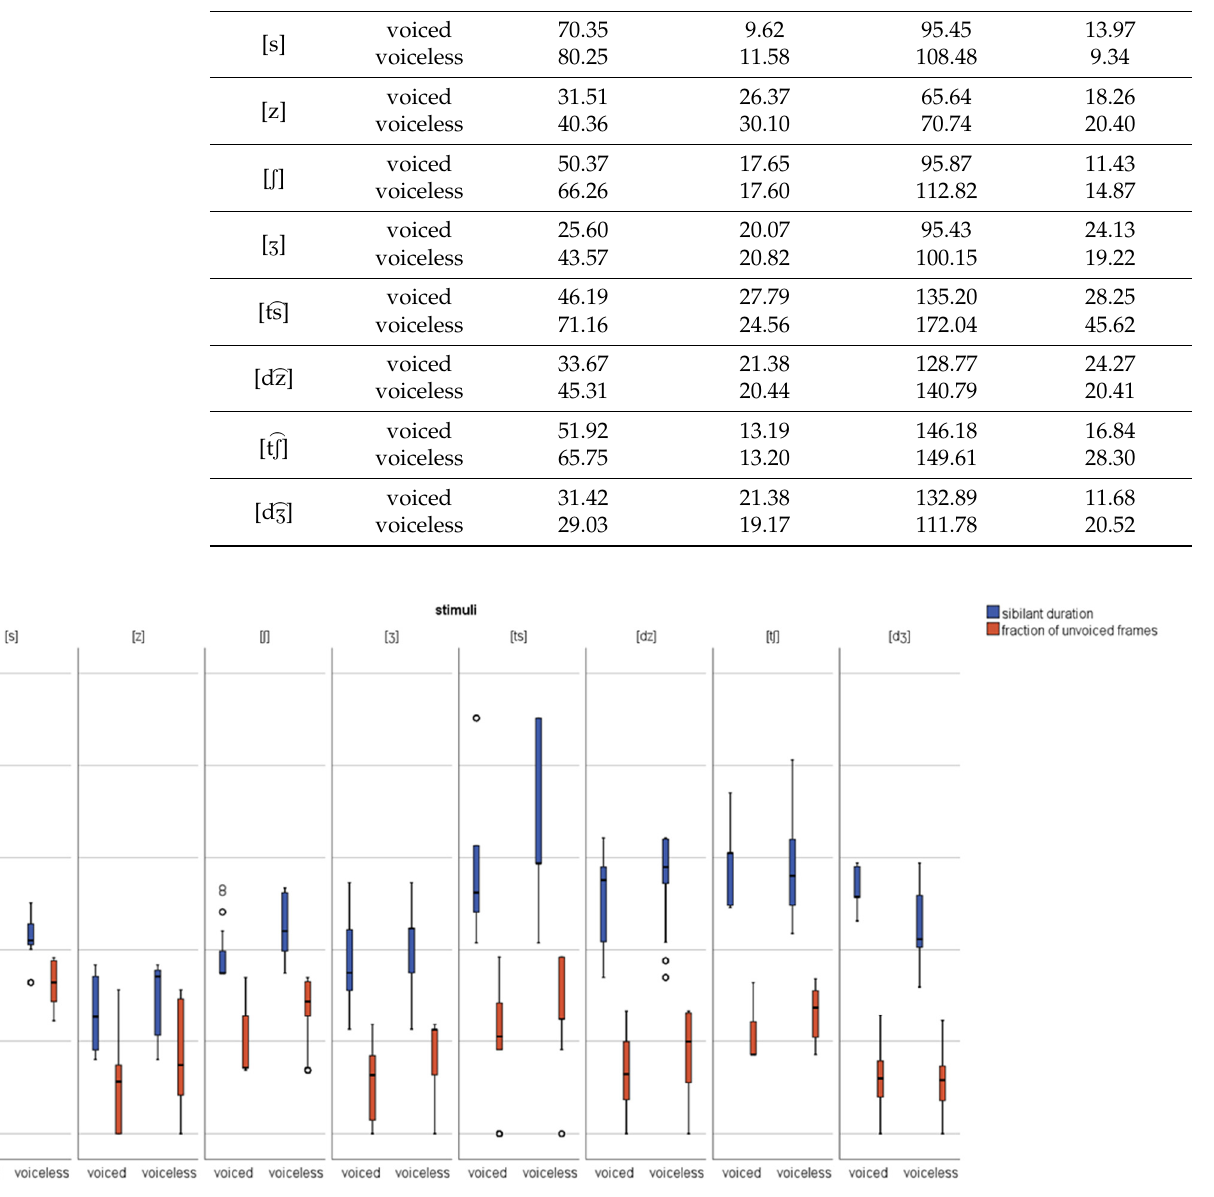
voiceless are in general longer and display a higher portion of unvoiced frames than those more cases than expected labelled as voiced when fraction of unvoiced frames and du- identified as voiced in every category, the only exception being [d ͡ ʒ ]. This general obser- ration increase (b 0 = 0.003, se = 0.001, t = 2.476, p < 0.013), though correct parsings still vation is confirmed by the statistical analysis. The mixed-effect binomial logistic regres- outweigh incorrect answers. Overall, the participants’ judgements confirm the acoustic sion (answer × fraction of unvoiced frames × duration) demonstrates that neither fraction measurements regarding duration and fraction of unvoiced frames, thus showing that of unvoiced frames nor duration condition the participant’s response as main effects; how- they are reliable parameters to establish voicing degree, which seem to be acoustically and ever, two- and three-way interactions (sibilant type × fraction of unvoiced frames, sibilant perceptually related. type × duration, sibilant type × fraction of unvoiced frames × duration) are significant. Table 9. Mean value of fraction of unvoiced frames (in percentages) and duration (in milliseconds) in the stimuli labelled as voiced or voiceless for every category. Standard deviation values are also provided. Fraction of Unvoiced Frames (%) Consonant Duration (ms.) Stimuli